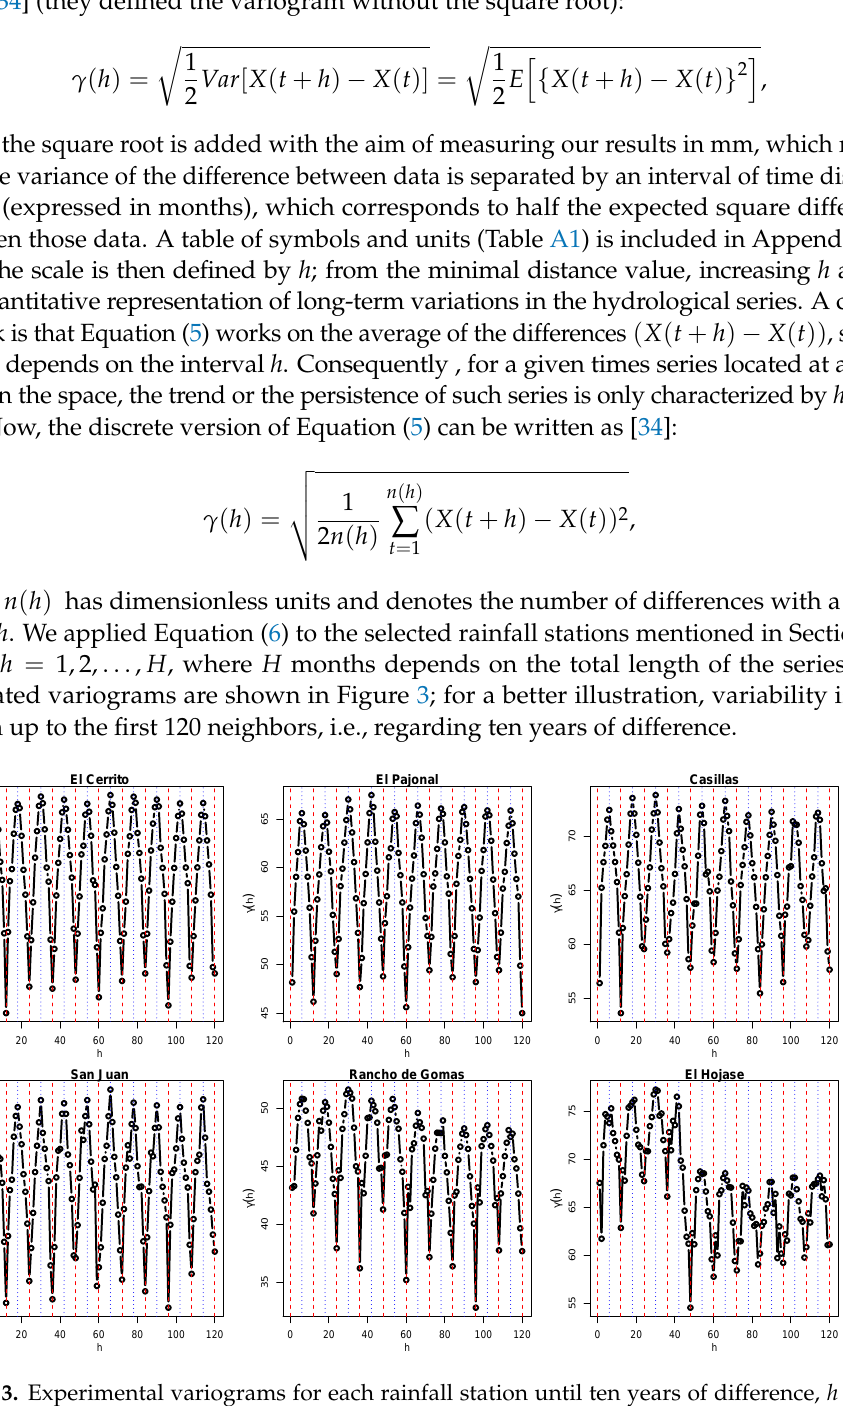
Figure 3. Experimental variograms for each rainfall station until ten years of difference, h = 120. Red dashed lines tag variability at 0,12,24, . . . ,120 months, while blue dotted lines tag variability at 6,18,30, . . . ,114